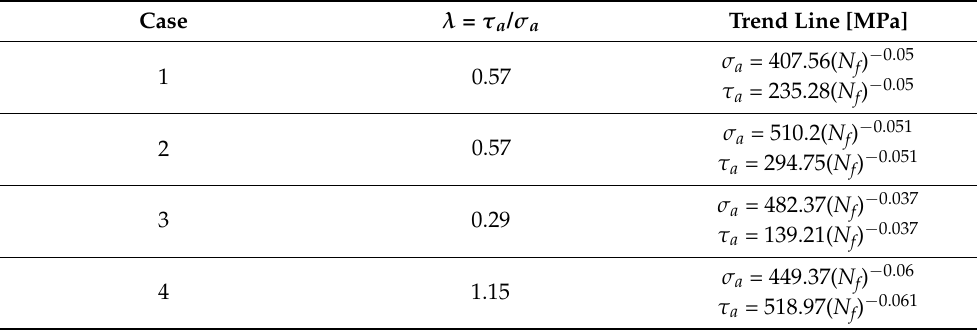
Table 4. S-N trend lines for normal and shear loading components of loading cases 1 to 4, experimen- tally evaluated for AISI303.